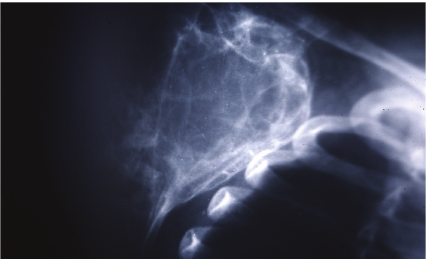
Figure 2: Preoperative scapular view radiograph of the right scapula.